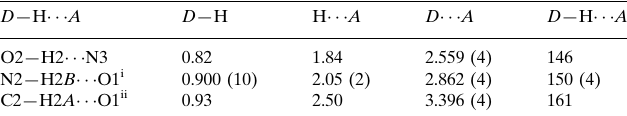
Hydrogen-bond geometry (A˚ , (cid:1)